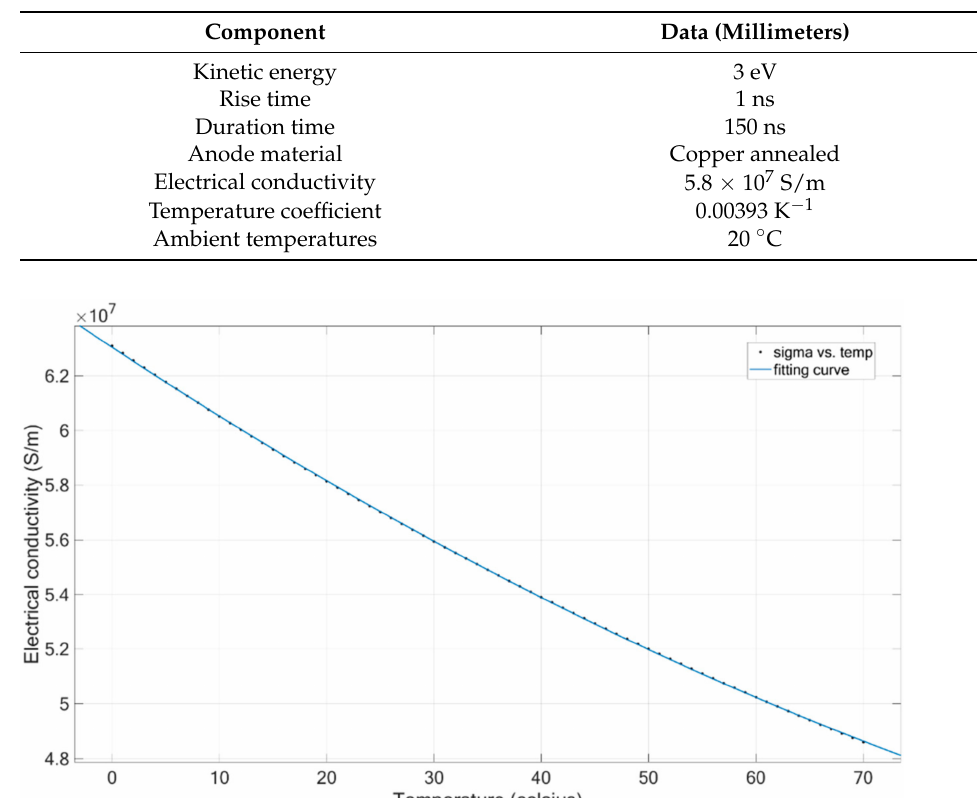
Figure 16. The electrical conductivity response after temperature